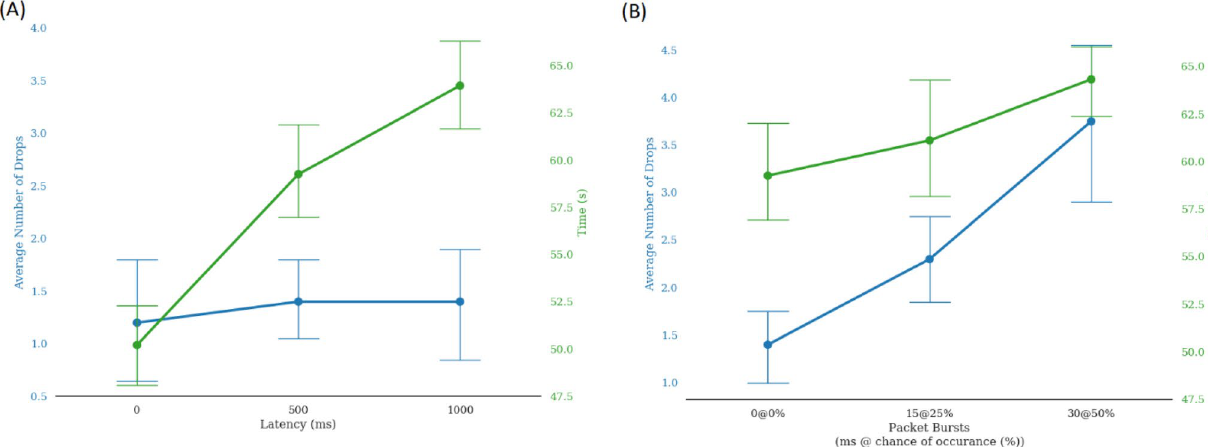
Figure 5. ( a ) The effect of latency on the number of errors (blue) and the completion time (green). ( b ) The effect of packet bursts on the number of errors (blue) and completion time(green).